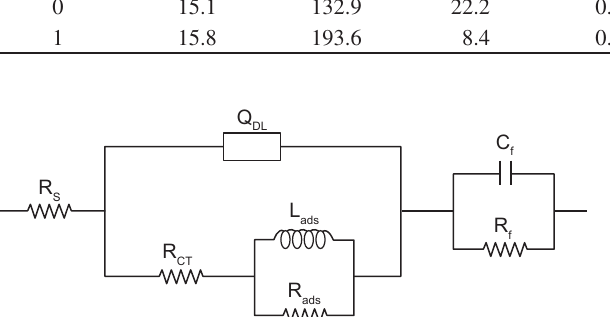
Table 4. Simulated data for the Ti electrode in fluoride containing citric acid solution. Potential V R ( Ω .cm 2 ) s